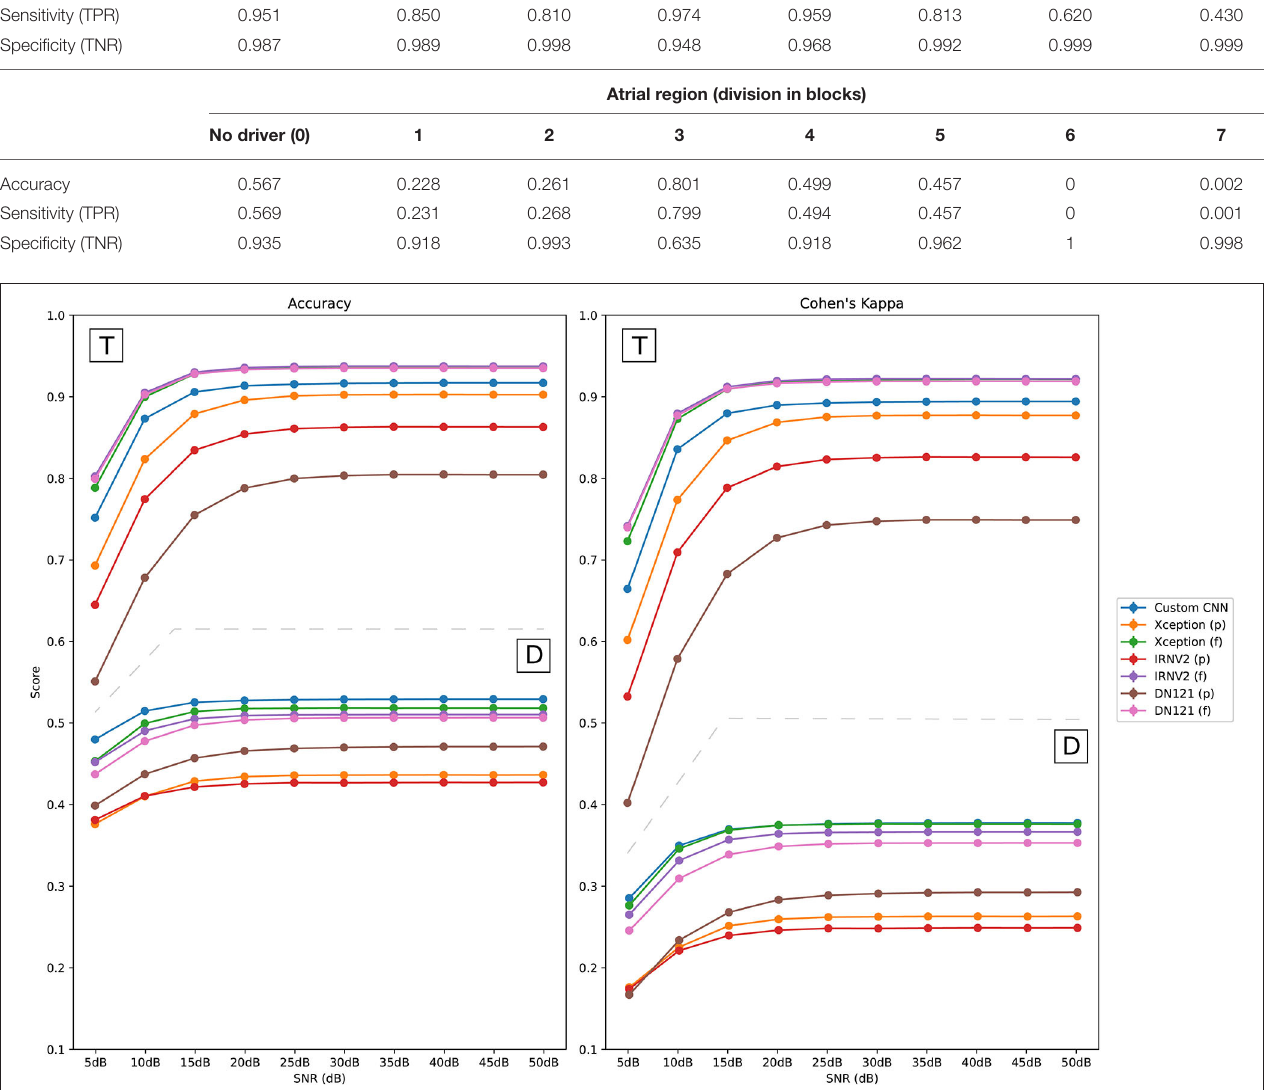
FIGURE 5 | Performance of CNN models on noisy test signals when assuming time independence (T) and division in blocks (D). Partially trained CNN models are marked with (p), and fully trained ones are identified as